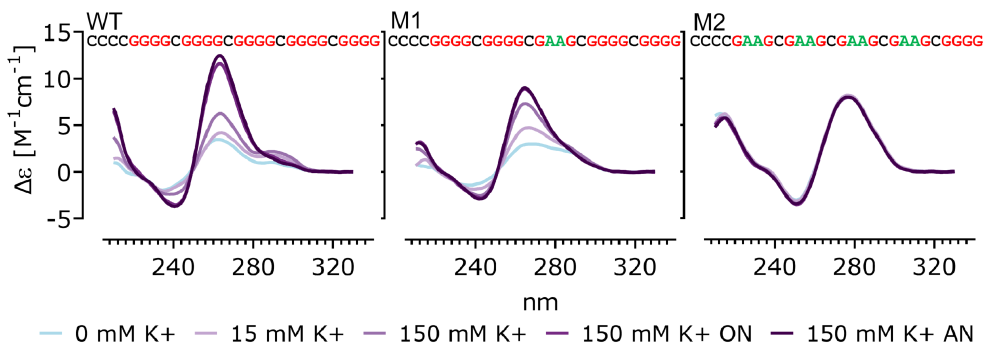
Figure 2. CD spectra of inserted sequences into Ty1his3-AI . CD spectra obtained in an increasing potassium concentration showing formation of quadruplex in WT and M1 but not in M2 (ON— overnight, AN—annealed). The sequences of tested oligonucleotides are shown with G-tracts highlighted by red and G to A substitutions by green